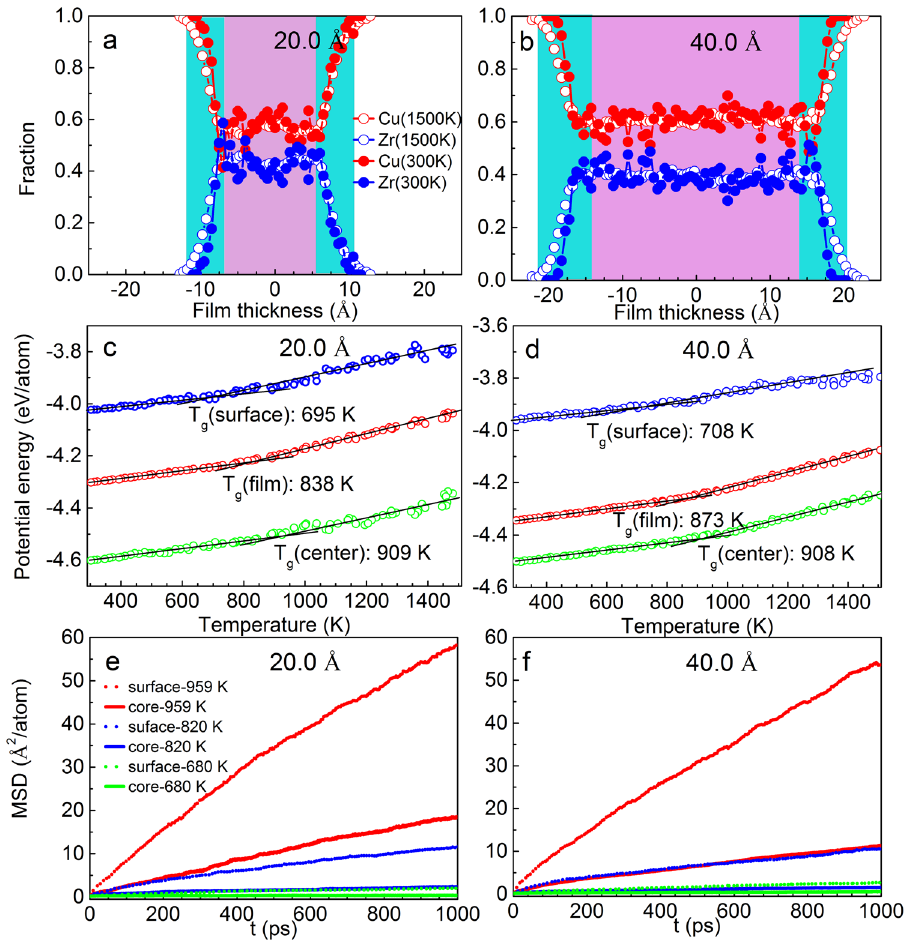
Figure 9. Composition variations along the film thickness for Cu 64 Zr 36 SSAFs with thicknesses of ( a ) 20.0 Å and ( b ) 40.0 Å. Determination of glass transition temperature T g (total, core and surface components) of ( c ) 20.0 Å and ( d ) 40.0 Å thick Cu 64 Zr 36 SSAFs. Mean atomic square displacements at two regions (core and surface) of ( e ) 20.0 Å and ( f ) 40.0 Å thick Cu 64 Zr 36 SSAFs at 680, 820 and 959